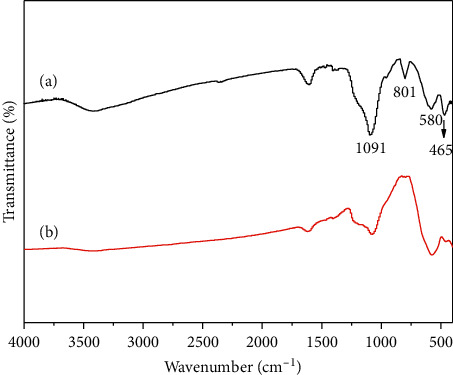
FT-IR spectra of CoFe2O4@SiO2 (a) and CoFe2O4 (b).